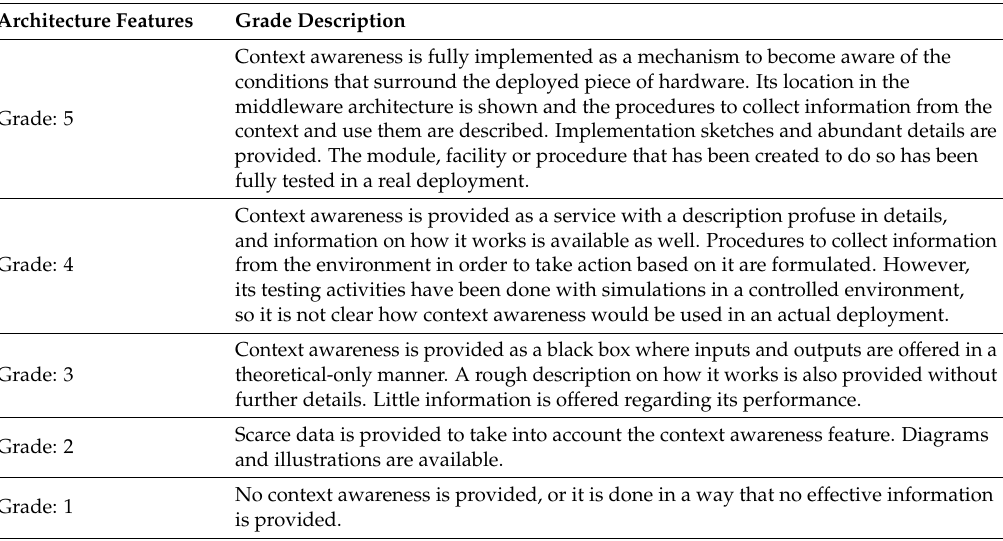
Table 7. Context awareness